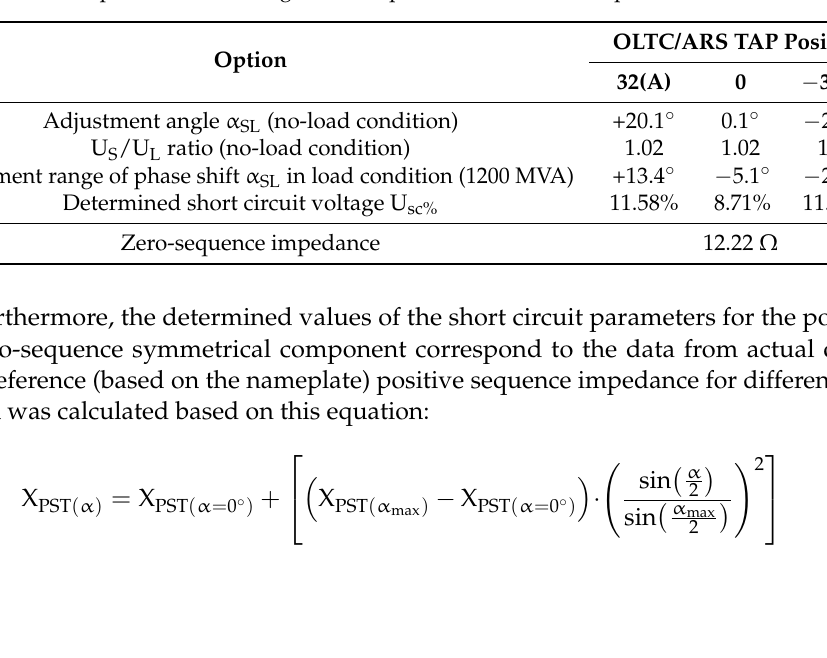
Table 3. Results of parameters and regulation capabilities of the developed PST